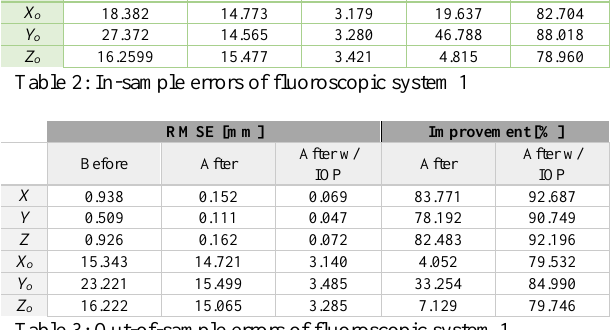
Table 3: Out-of-sample errors of fluoroscopic system